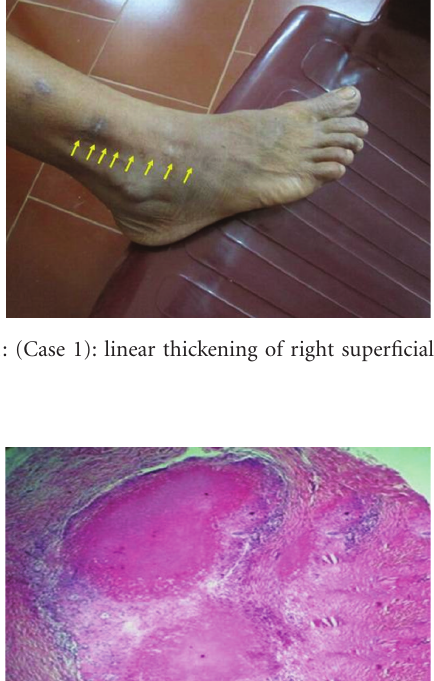
Figure 5: (Case 2): thickened left ulnar nerve with nodule (circled) and skin lesions